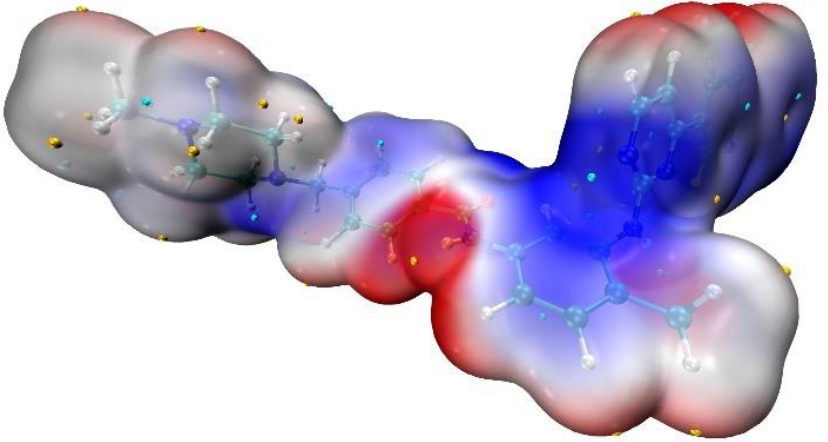
Figure 4. Experimental molecular electrostatic potential of free-base Imatinib mapped on the 0.001 a.u. isosurface of charge density ranged from –0.019 a.u. (blue) to 0.014 a.u. (red). The negative and positive local maxima are pointed out by small blue and yellow spheres.